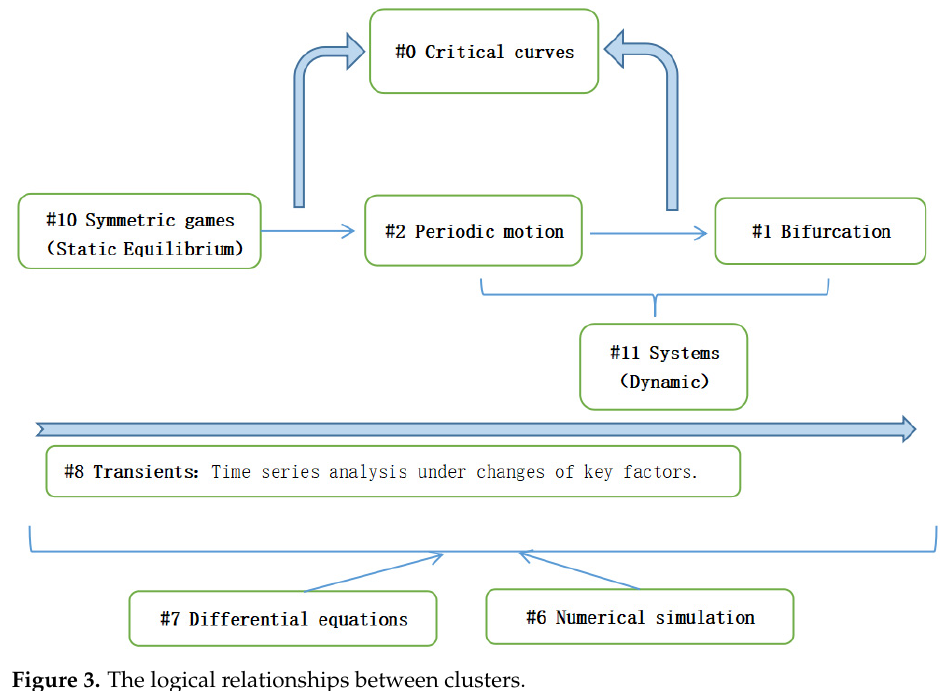
Figure 3. The logical relationships between clusters.